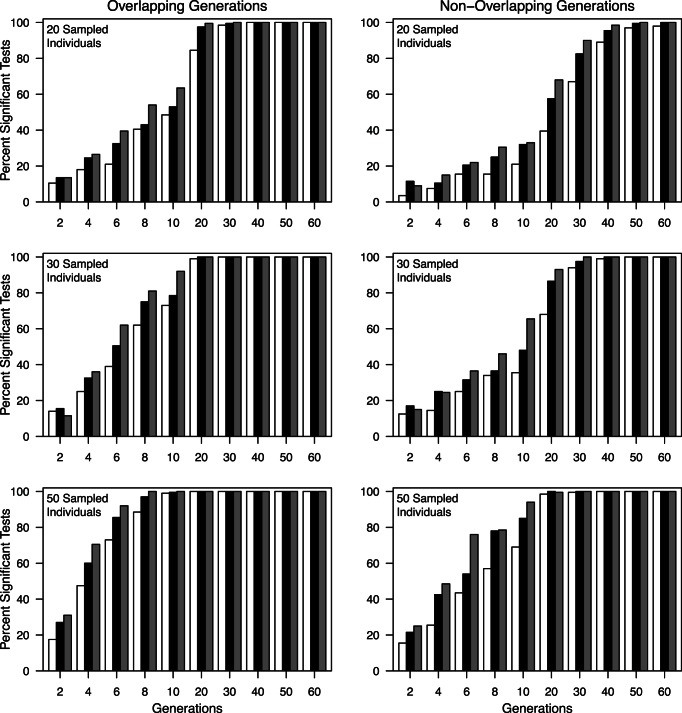
Effect of number of individuals (20, 30 and 50), number of loci (10, 15, 20), and overlapping versus non-overlapping generations on the percentage of the 200 replicate runs that yielded significant Dest_Chao values 2 to 50 generations after cessation of migration for N
max = 3000.Closed bars 10 loci, open bars 15 loci, grey bars 20 loci. Data for θ, MI, and G’st are nearly identical and are not shown.